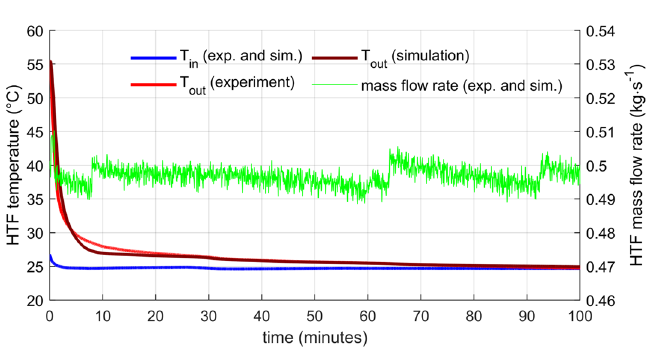
Figure 9. HTF temperature evolution—comparison of the numerical model with the experimental data for higher HTF flow rate. The greatest discrepancy was between 5 and 15 min.